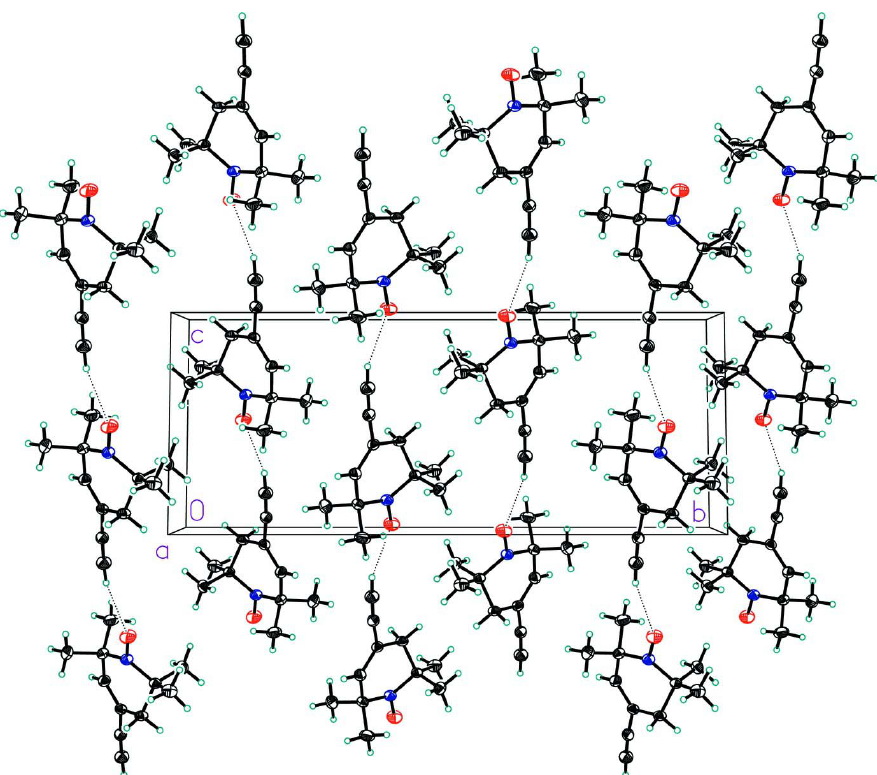
—H···O contacts are shown as ethynyl